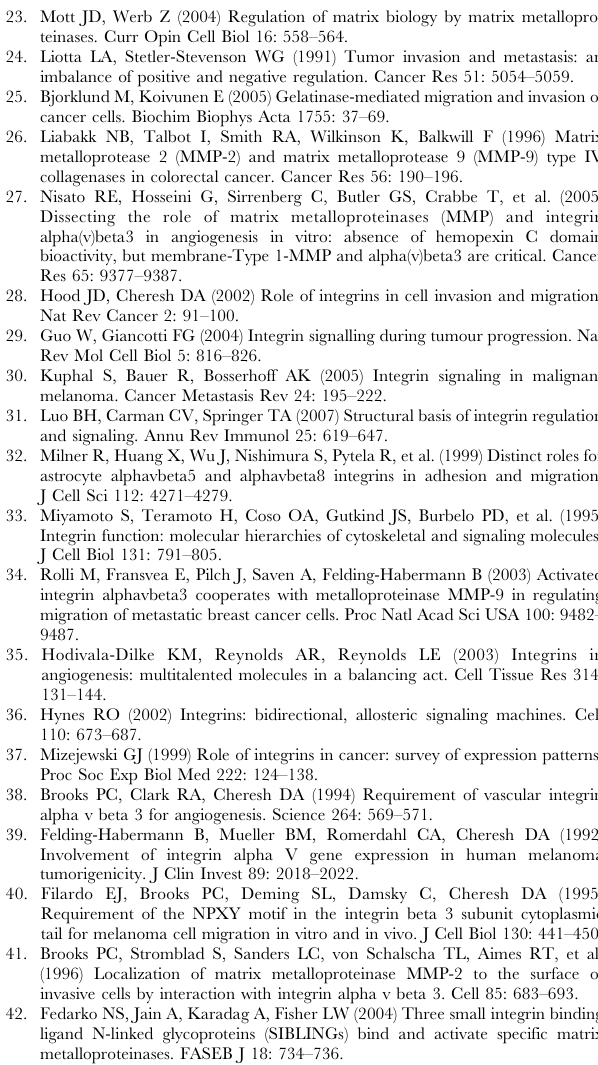
direction and distance of cell migration. Scale bar represents 100 m m. (D) Photomicrograph of the effects of MMP-2I on DU145 cell migration 24 after seeding in the transwell. Scale bar =100 m